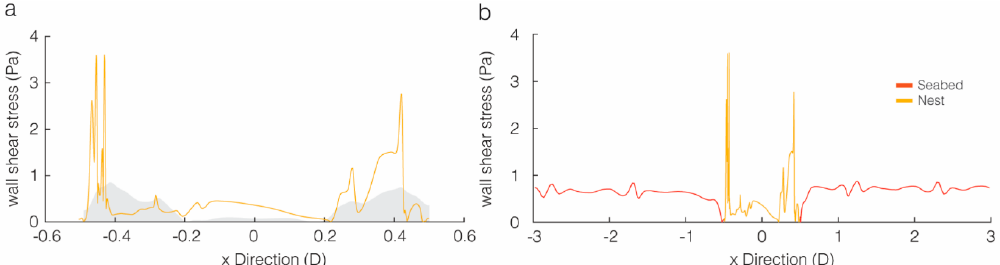
Figure 15. Wall shear stress distribution along the nest and surrounding seabed in terms of nest diameter D. ( a ) Wall shear stress distribution within the nest; ( b ) Comparison of the surrounding seabed wall shear stress distribution against the wall shear stress within the nest.